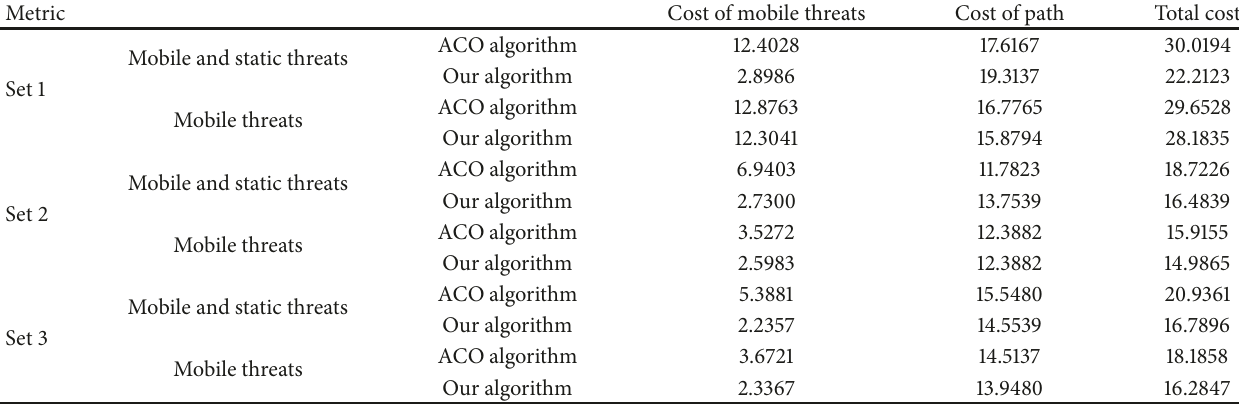
Table 1: Performance evaluations on optimal planning paths between different